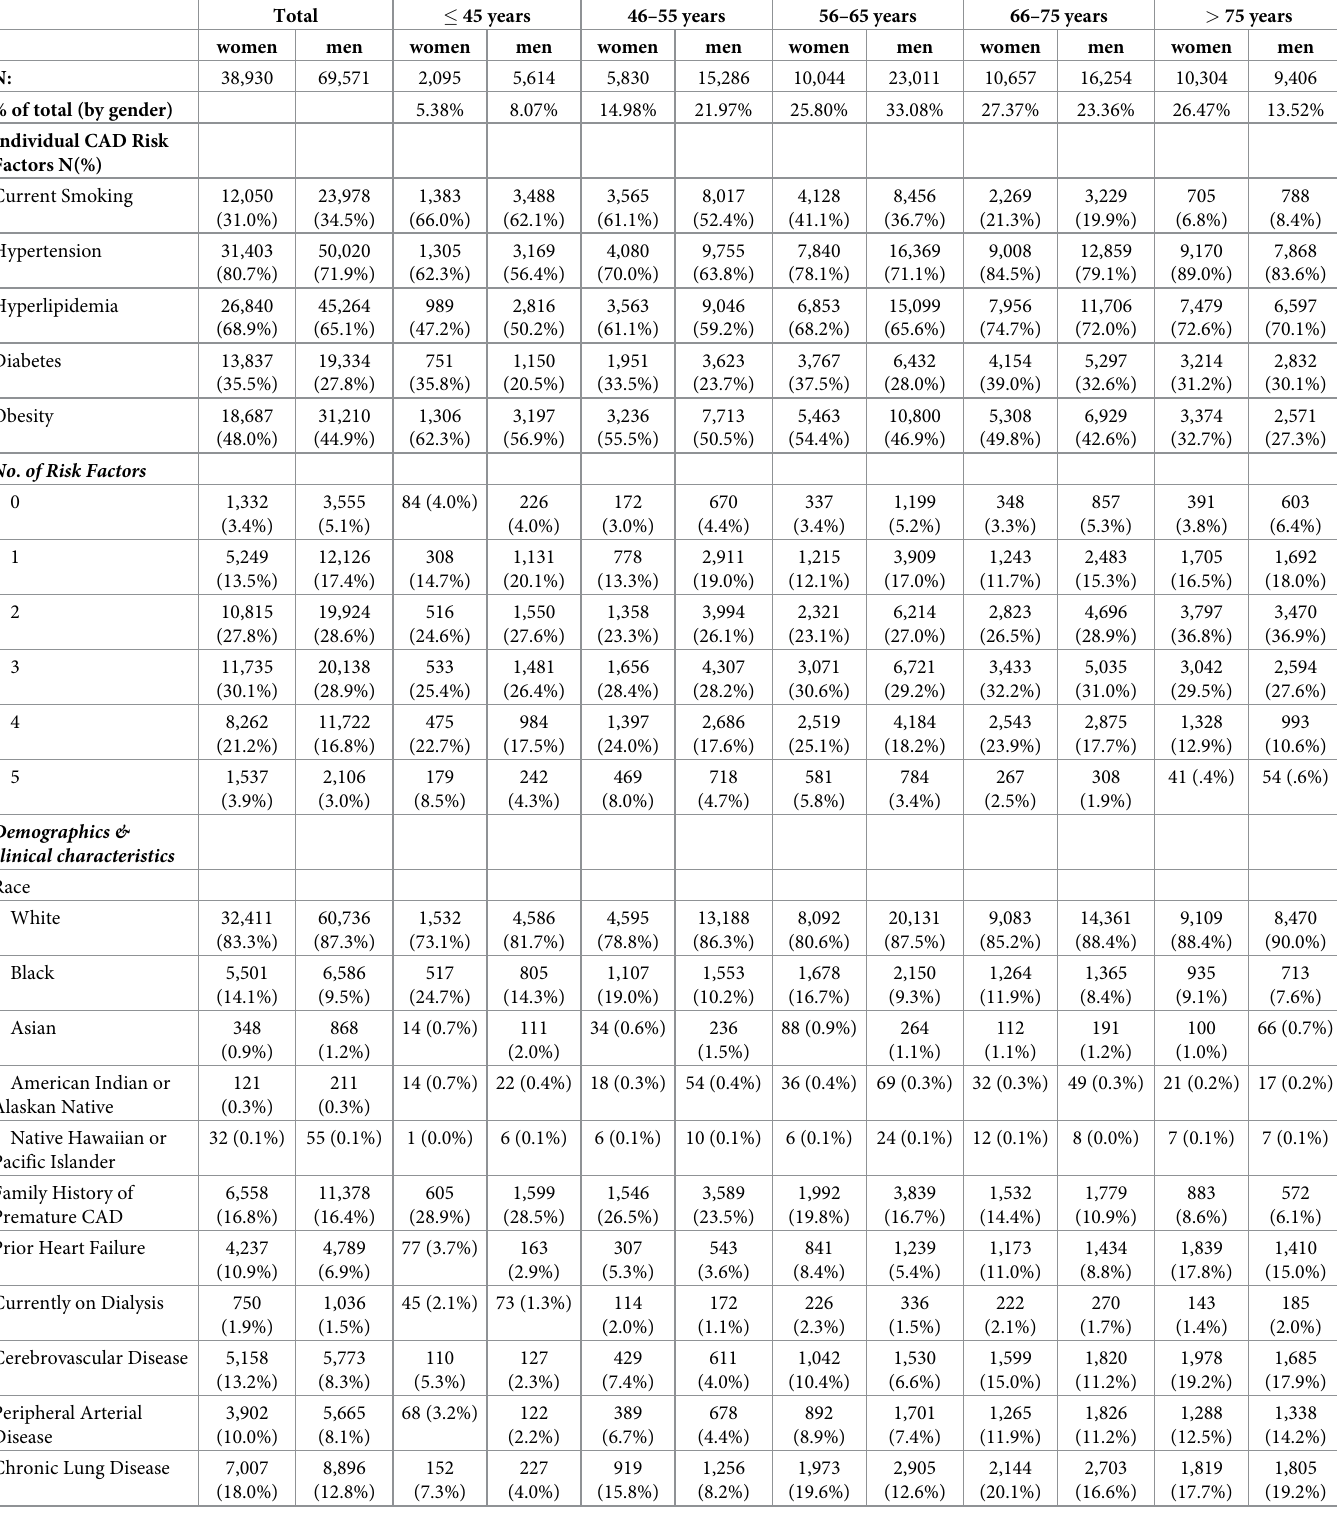
Table 1. Risk factor profile and baseline characteristics by age and